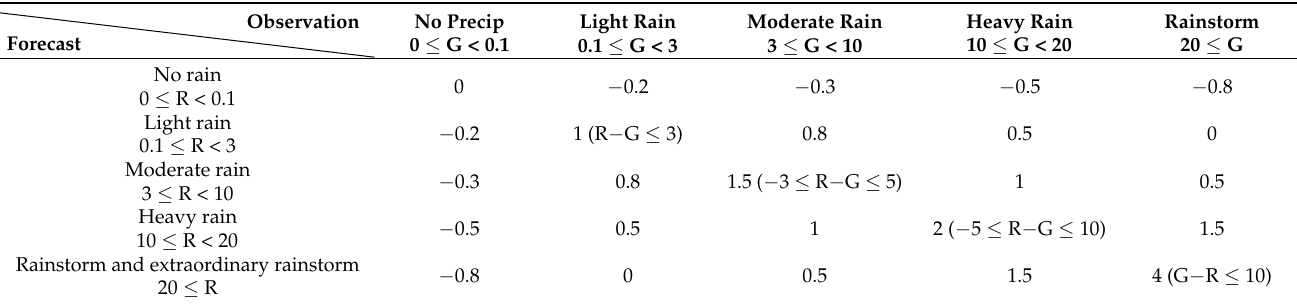
Table 3. Cross-magnitude weight method